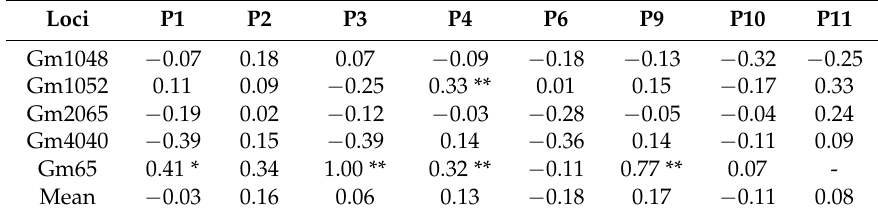
Table 6. Fixation index ( F ) and Hardy-Weinberg equilibrium chi-square tests of all loci in populations of Erythrophleum fordii .